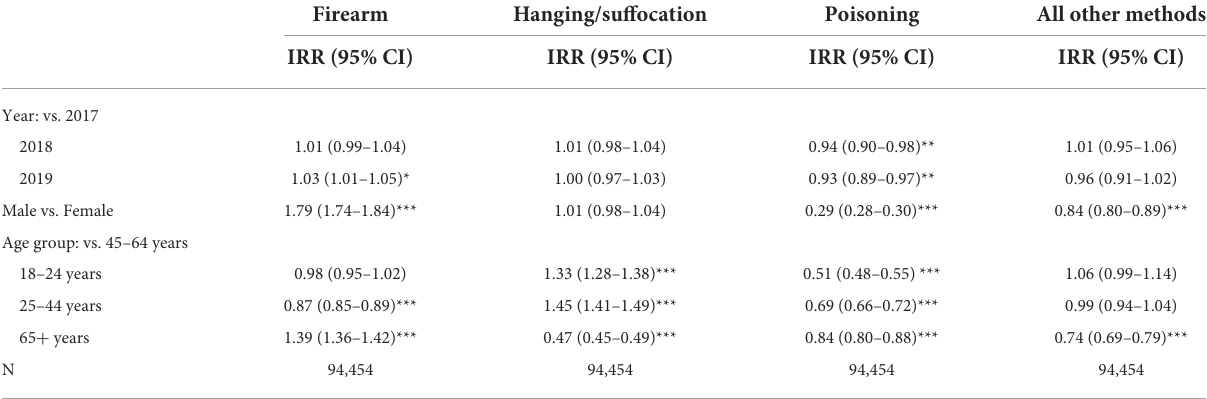
TABLE 2 Changes in suicide methods, 2017-2019, controlling for age and sex: Results from generalized linear models for a Poisson distribution with a log link. Firearm